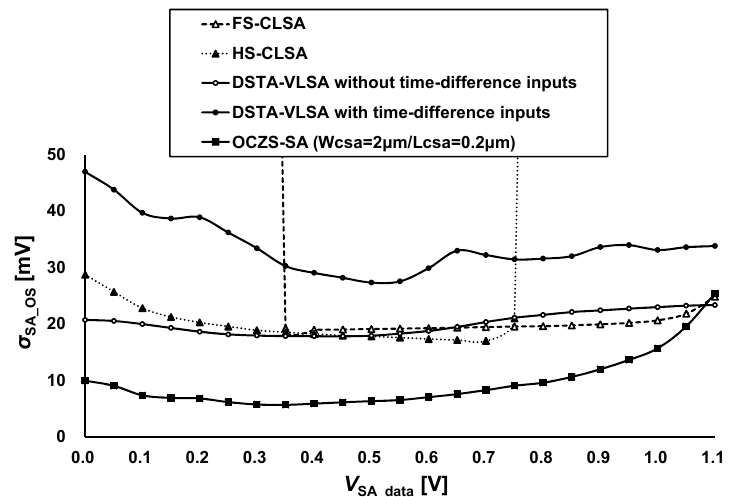
Figure 8. σ SA_OS according to the SA input voltage ( V SA_data ) for FS-CLSA, HS-CLSA, DSTA-VLSA without time-different inputs, DSTA-VLSA with time-difference inputs, and OCZS-SA. The OCZS-SA achieves σ SA_OS of 9.62 mV on average (minimum σ SA_OS = 5.07 mV at V SA_data = 0.3 V; maximum σ SA_OS = 25.41 mV at V SA_data = 1.1 V).